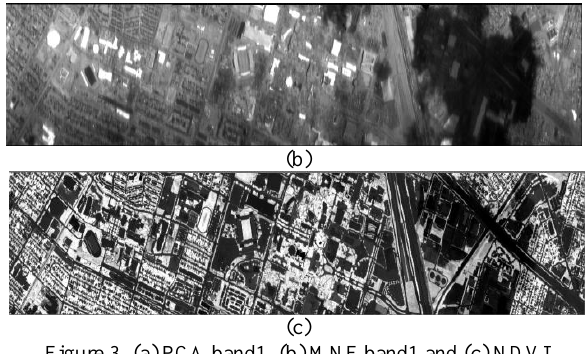
Figure 3. (a) PCA band1, (b) MNF band1 and (c) NDVI